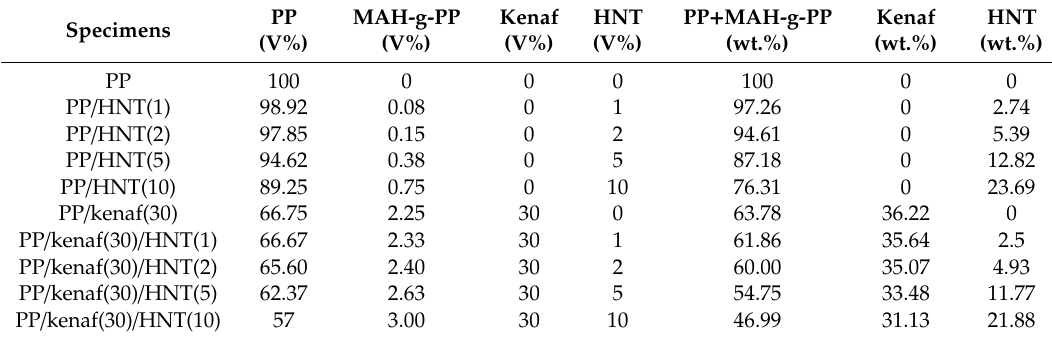
Table 1. Di ff erent compositions of PP / HNTs nanocomposites, PP / kenaf / HNTs nano-biocomposites, and reference PP / kenaf fiber